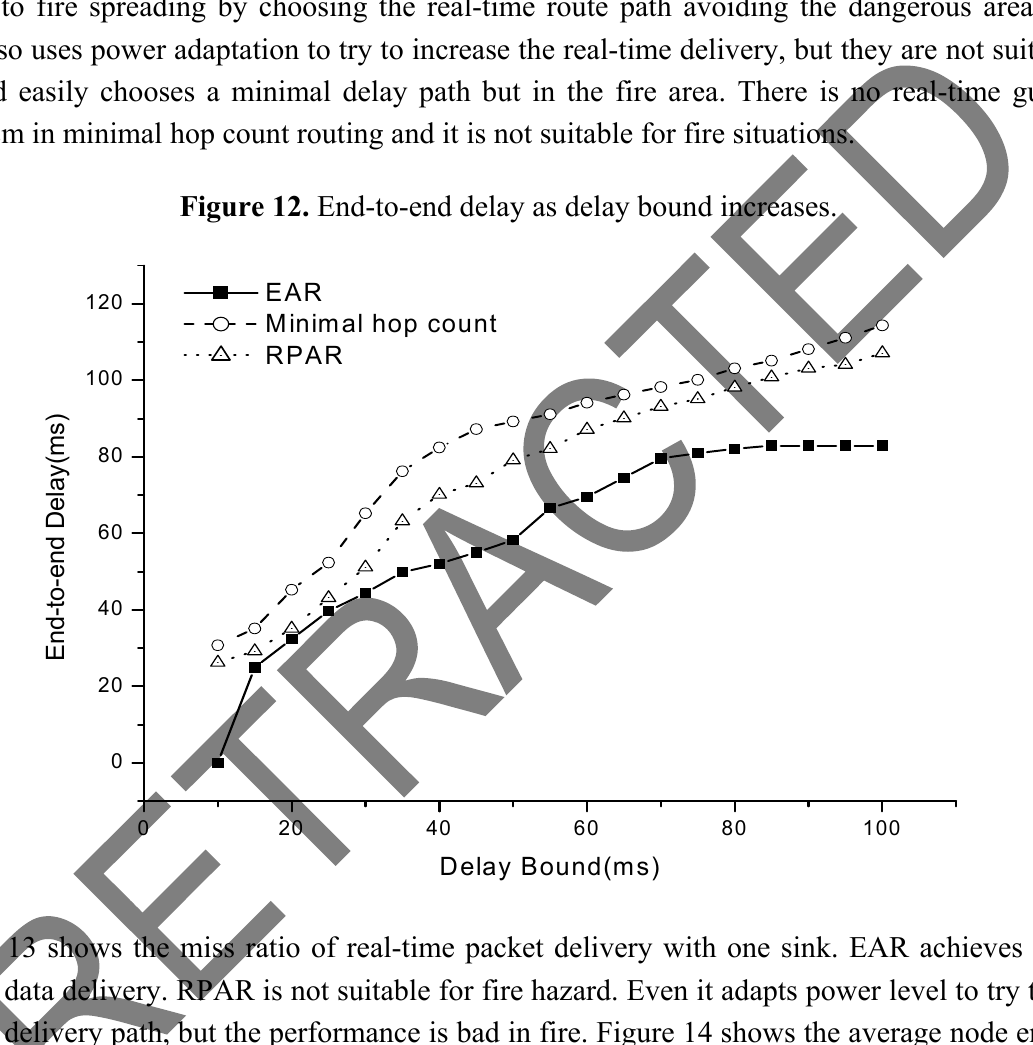
Figure 12. End-to-end delay as delay bound